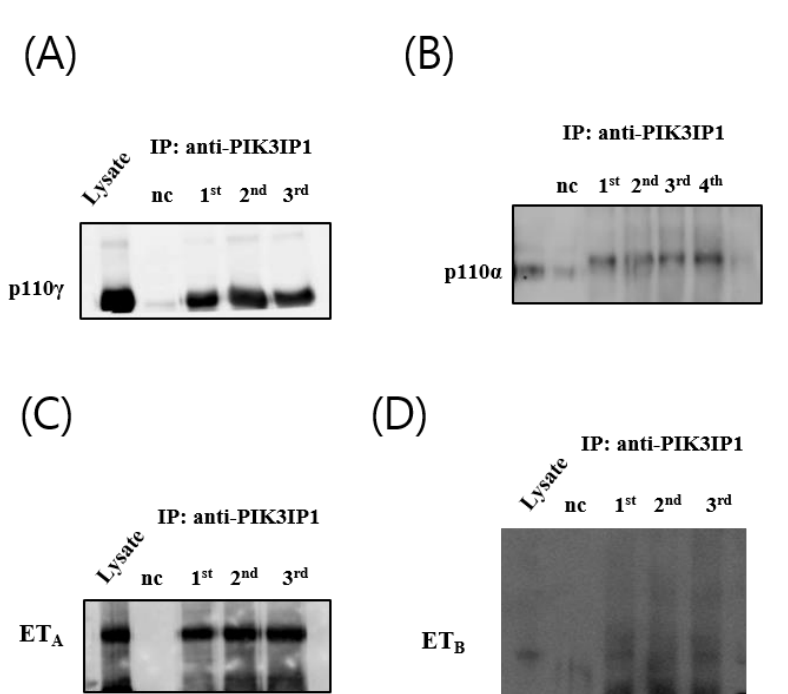
Figure 4. PIK3IP1 binds with p110α, p110γ , and ET A , but not with ET B . Co-immunoprecipitation (Co-IP) assays using H9c2 cells were detected via Western blotting using the anti-PIK3IP1 and ( A ) anti- p110α antibody, ( B ) anti- p110γ antibody, ( C ) anti-ET A antibody, and ( D ) anti-ET B antibody. The mock IP negative control experiment was performed by incubating cell extracts with G Dynabeads coupled with rabbit IgG.